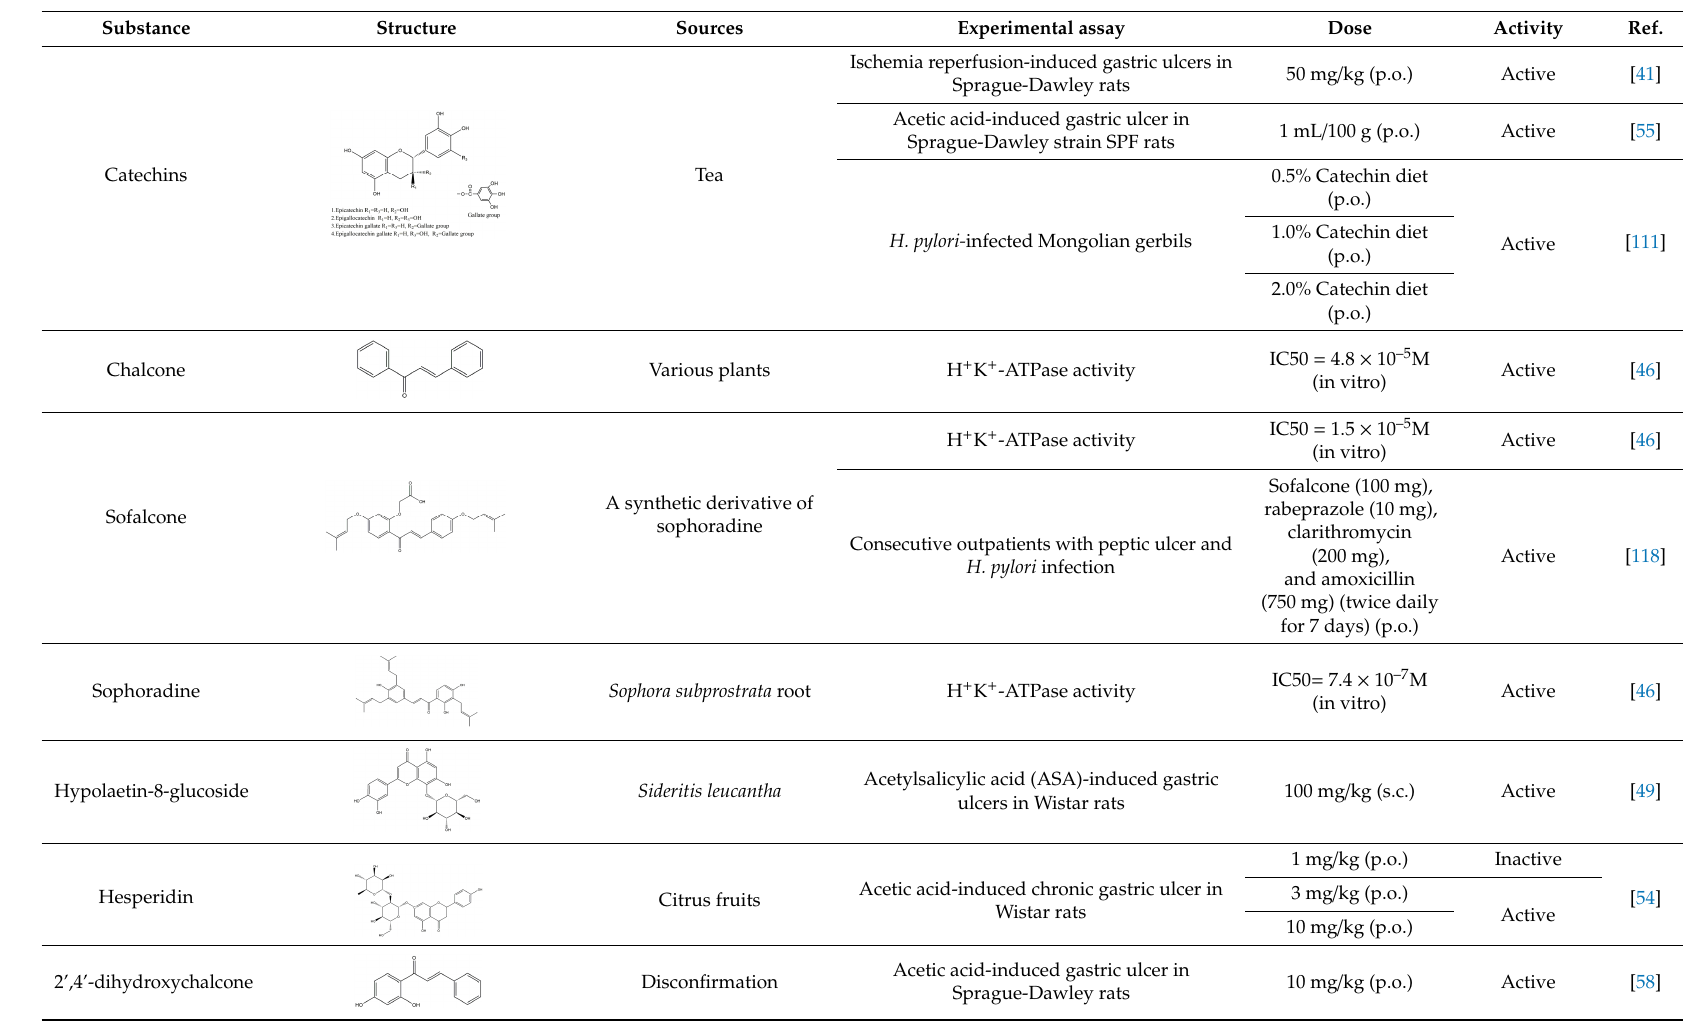
Table 2. Studies on the treatment of peptic ulcer with flavonoids.